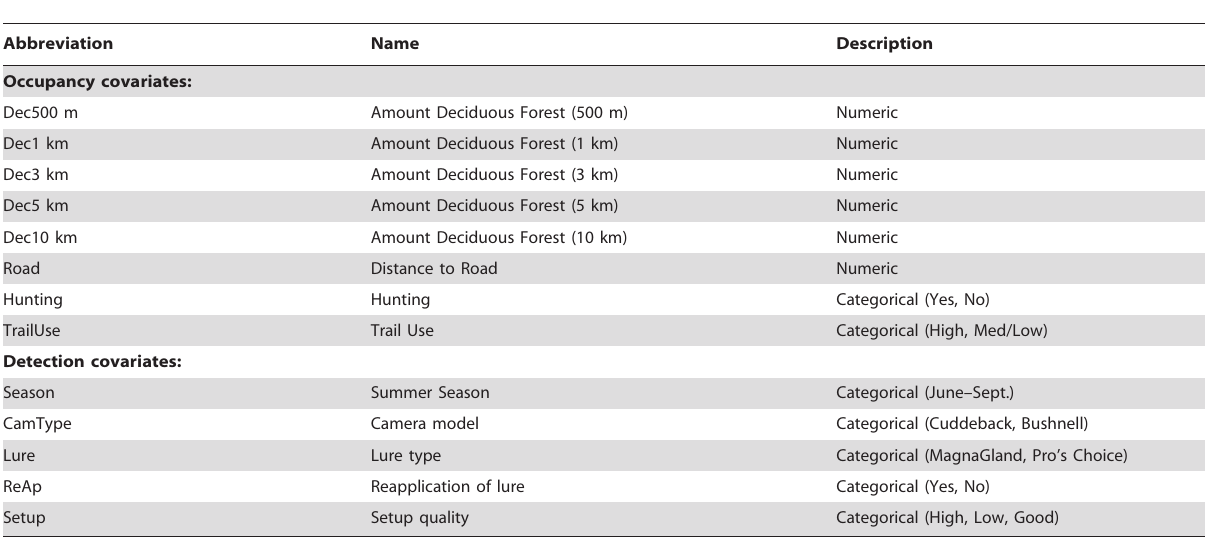
Table 1. Covariates used to model occupancy and detection probabilities.